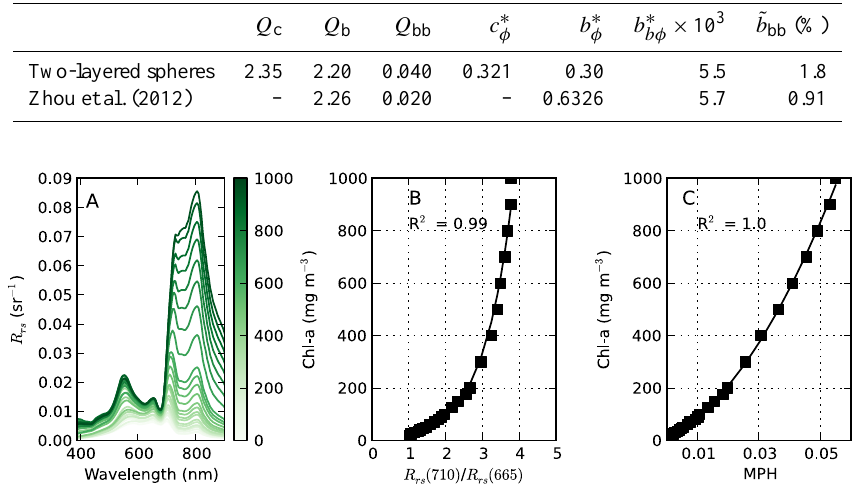
Table 4. Optical efficiency factors and Chl a -specific volume coefficients (m 2 mg − 1 ) at 510 nm for a population of M. aeruginosa modelled as a population of two-layered spheres with shell layer 1+ (cid:15) =1.12 and V g =50%.